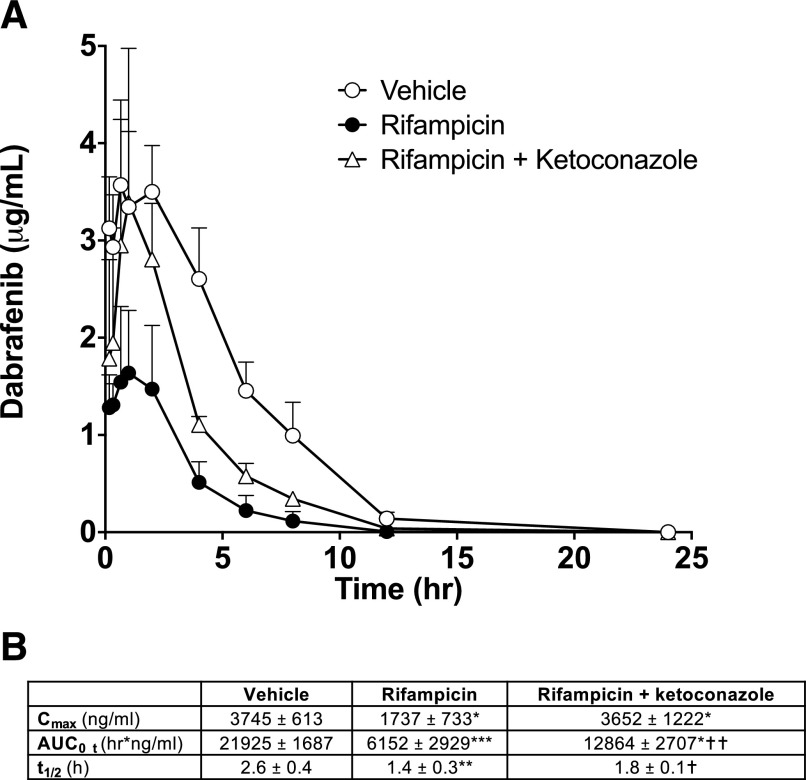
Effect of rifampicin and ketoconazole on dabrafenib pharmacokinetics. (A) Adult female 8HUM mice (n = 3) were treated with vehicle (corn oil, open circles) or rifampicin (10 mg/kg, closed circles) intraperitoneally daily for 3 days, with one of the latter groups receiving a dose of the CYP3A4 inhibitor ketoconazole (20 mg/kg PO, open triangles) 30 minutes before all groups were administered dabrafenib (10 mg/kg, PO), and PK profiling was carried out as described in Materials and Methods. (B) Pharmacokinetic parameters from the profiles shown in (A). Data shown are mean ± S.D. *P ≤ 0.05; **P ≤ 0.01; ***P ≤ 0.001 for vehicle vs. rifampicin and rifampicin vs. rifampicin + ketoconazole, t test. †P ≤ 0.05; ††P ≤ 0.01; for Vehicle vs. rifampicin + ketoconazole, t test.